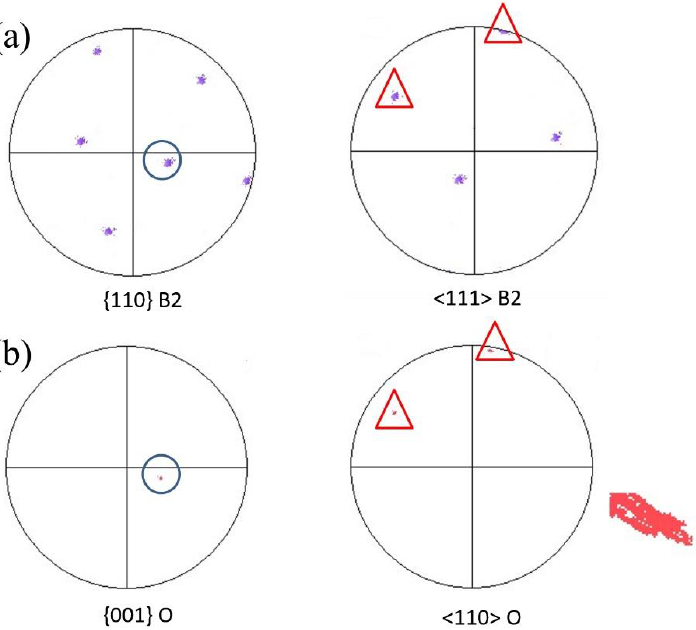
Figure 10. ( a ) {110} and <111> pole figures of the B2 phase, ( b ) {001} and <110> pole figures of the red lamellar O phase.